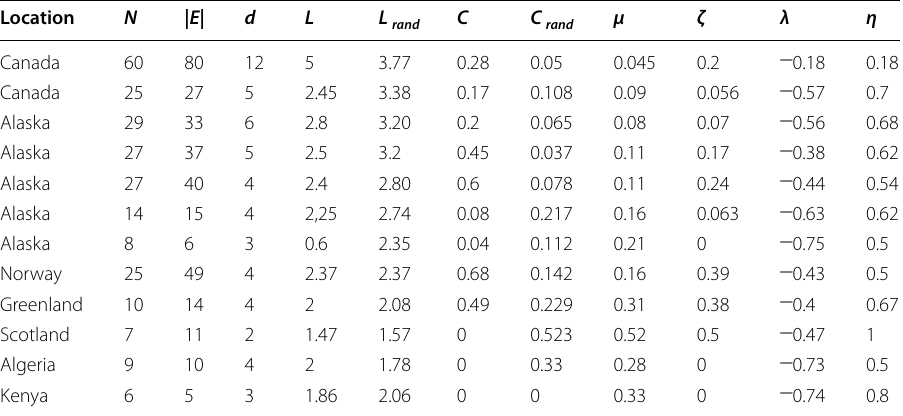
Table 6 Basic topological properties of the significant small local components (size greater than five